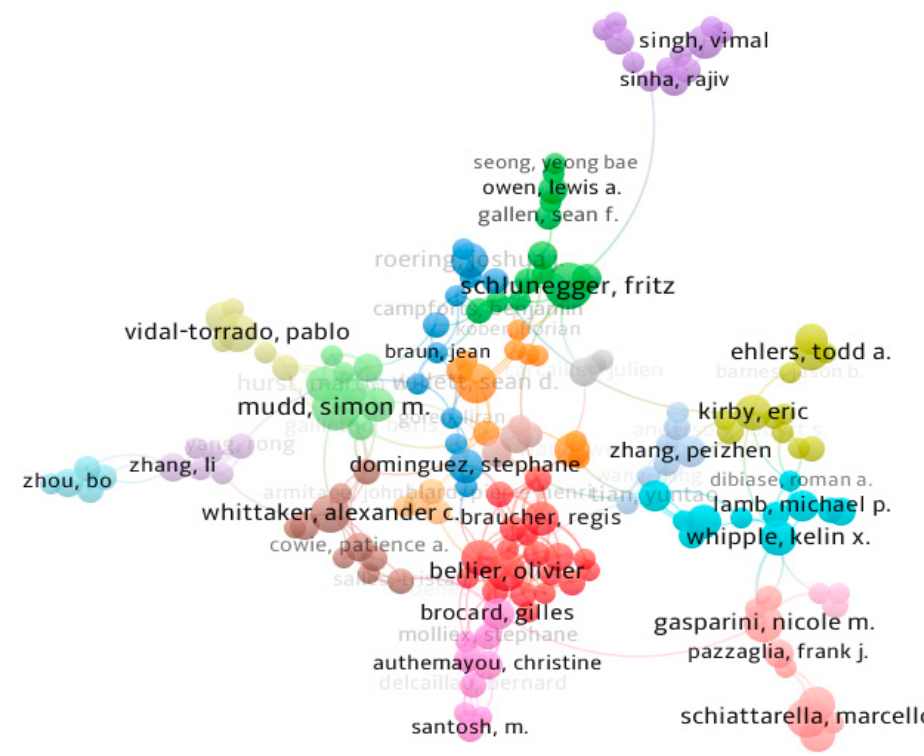
Figure 5. Authors network on tectonic geomorphology research in